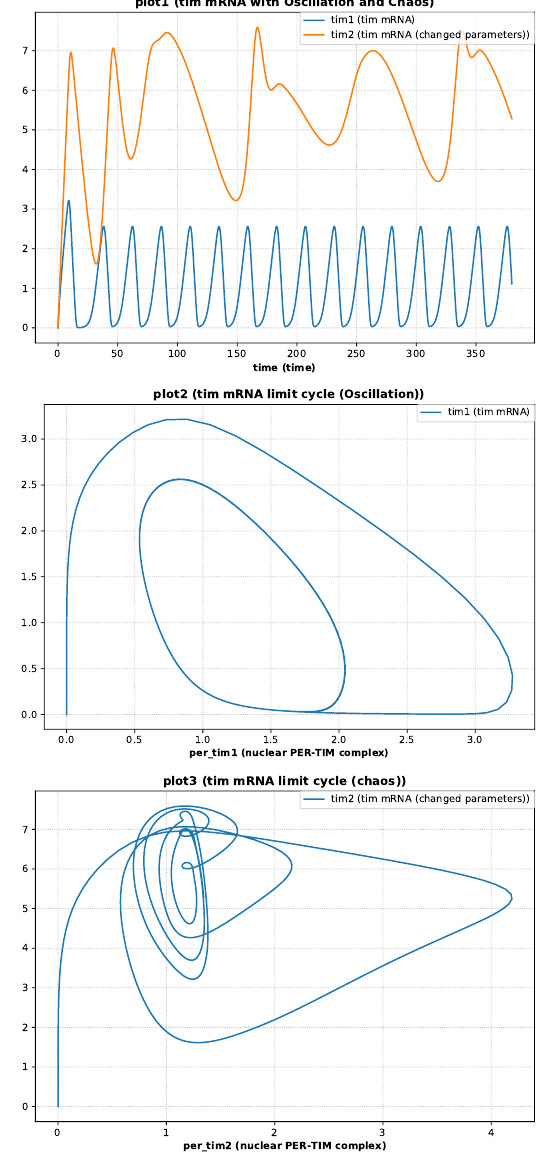
Figure A.18: Simulation with tellurium